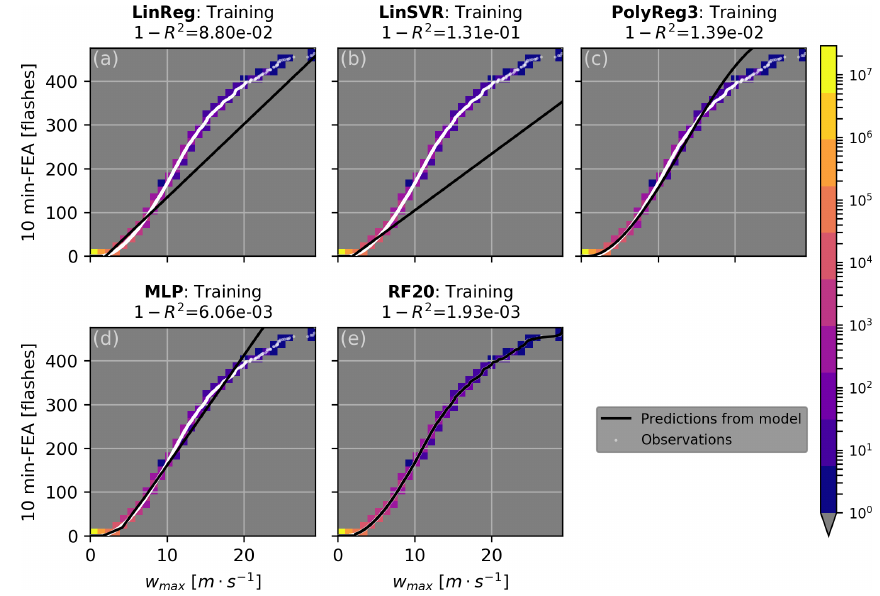
Figure 7. Same as Fig. 6 but for the maximum vertical velocity (wmax) and number of points in the bin of 0.974ms − 1